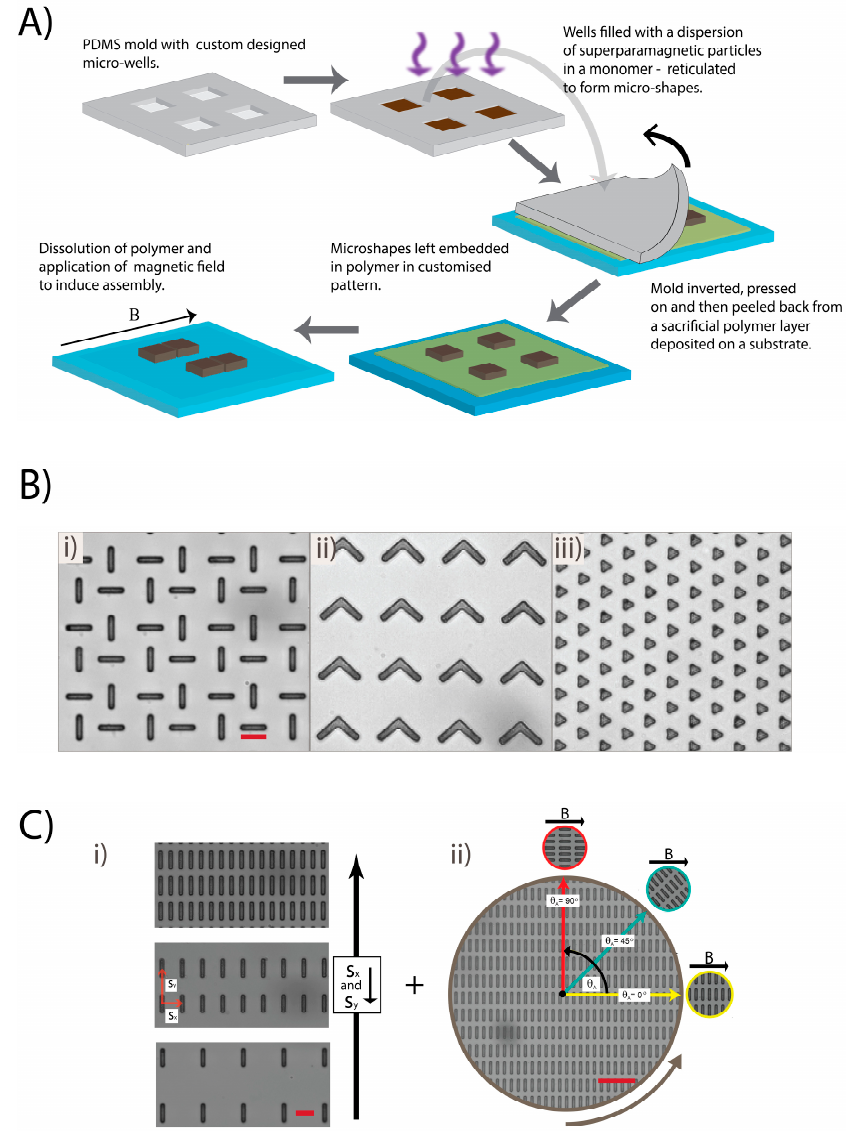
Figure 1. ( A ) The underlying method facilitating APPS: fabrication of SP micron-sized particles and there extraction onto a substrate. ( B ) SP rectangles (i), ‘boomerangs’ (ii), and triangles (iii) developed and extracted by the described method in three different prearrangements. Scale bars are 20 μ m. ( C ) The assembly variables studied: array pitch (i) and angle of the array with respect to a magnetic field maintained in the x direction (ii). Scale bars are 20 and 60 μ m for (i) and (ii), respectively.